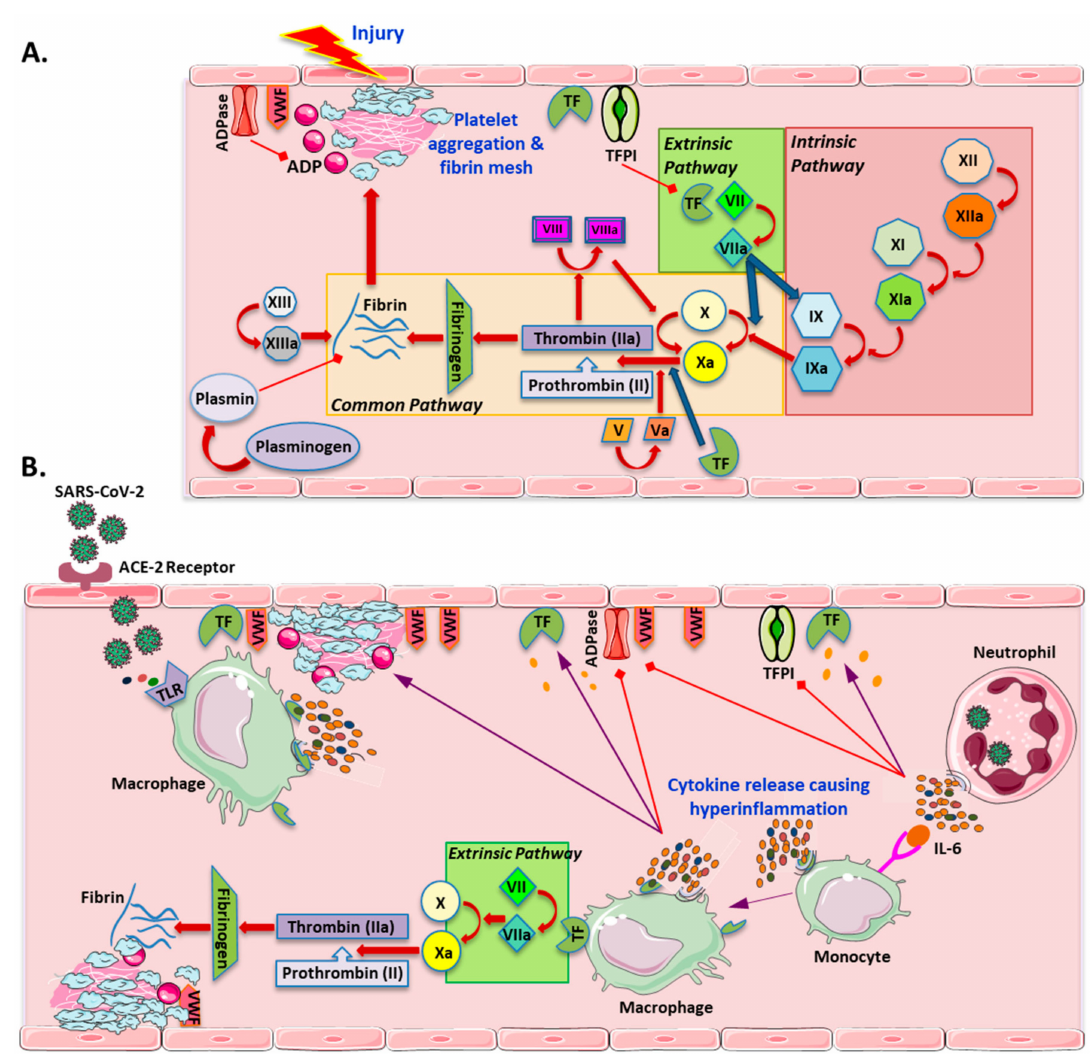
Figure 1. Schematic representation of ( A ) the normal coagulation cascade triggered by an injury to the endothelial cells and ( B ) the hypercoagulability state related to SARS-CoV-2 infection. Generally, with an injury to the endothelial cell, the first response is platelet aggregation, followed by the activation of both the extrinsic and intrinsic pathways that lead to the generation of factor Xa and common pathway initiation. The product of the secondary coagulation cascade is a fibrin clot which will enhance platelet aggregates. ADPase and tissue factor (TF) pathway inhibitors (TFPI), as well as plasminogen, act as regulatory anticoagulants. The extrinsic and common pathways are initiated due to the increased TF and von Willebrand factor (VWF) in response to inflammatory cytokines such as interleukin (IL)-6 and the expression of TF by mononuclear cells in response to IL-6, which is elevated in SARS-CoV-2 infection. TFPI and ADPase are inhibited by the cytokines as